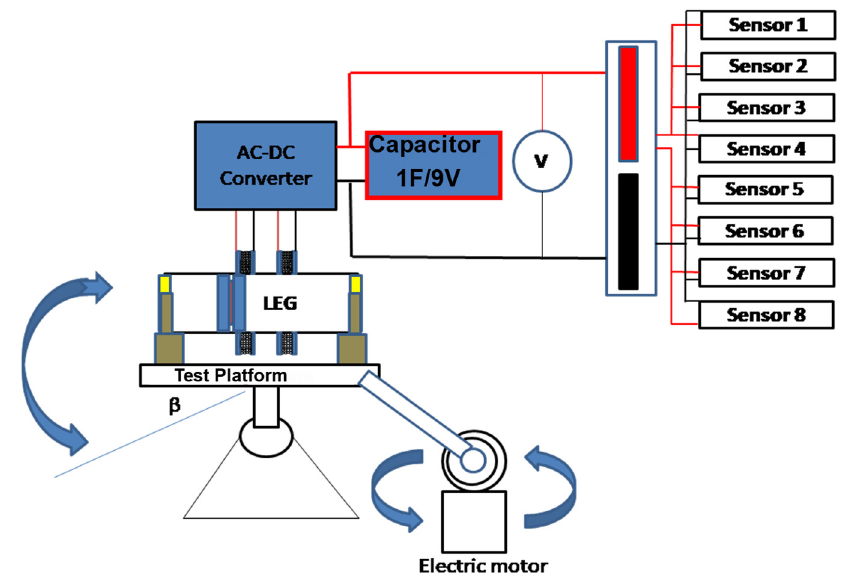
Figure 4. Equipment for testing different frequencies in the LEG.